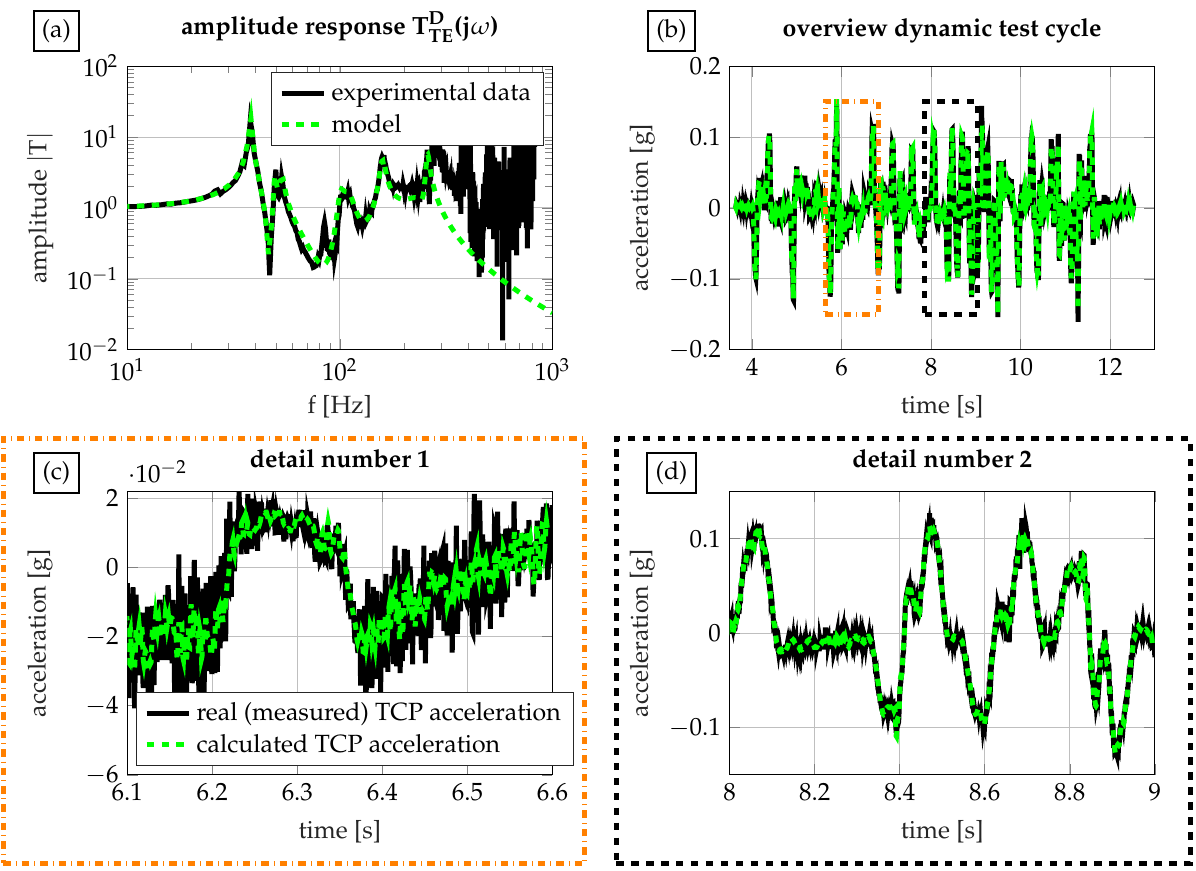
Figure 9. ( a ) measured and fitted TMF, ( b ) overview over the test cycle and the corresponding accelerations, ( c ) detailed comparison between the measured signal (black) and the outcome of the VS (green), ( d ) detail